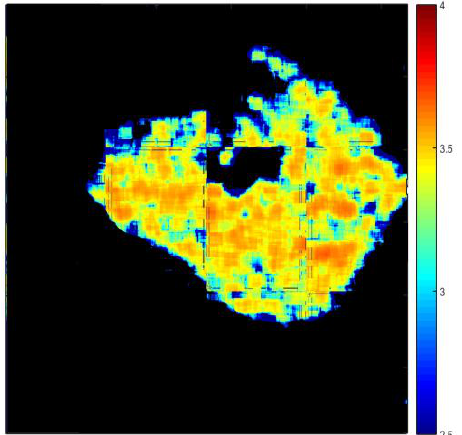
Figure 8. Age map of the floor of crater Tsiolkovsky using the CSFD obtained by the template matching method with an optimal threshold value, without the SCD algorithm.